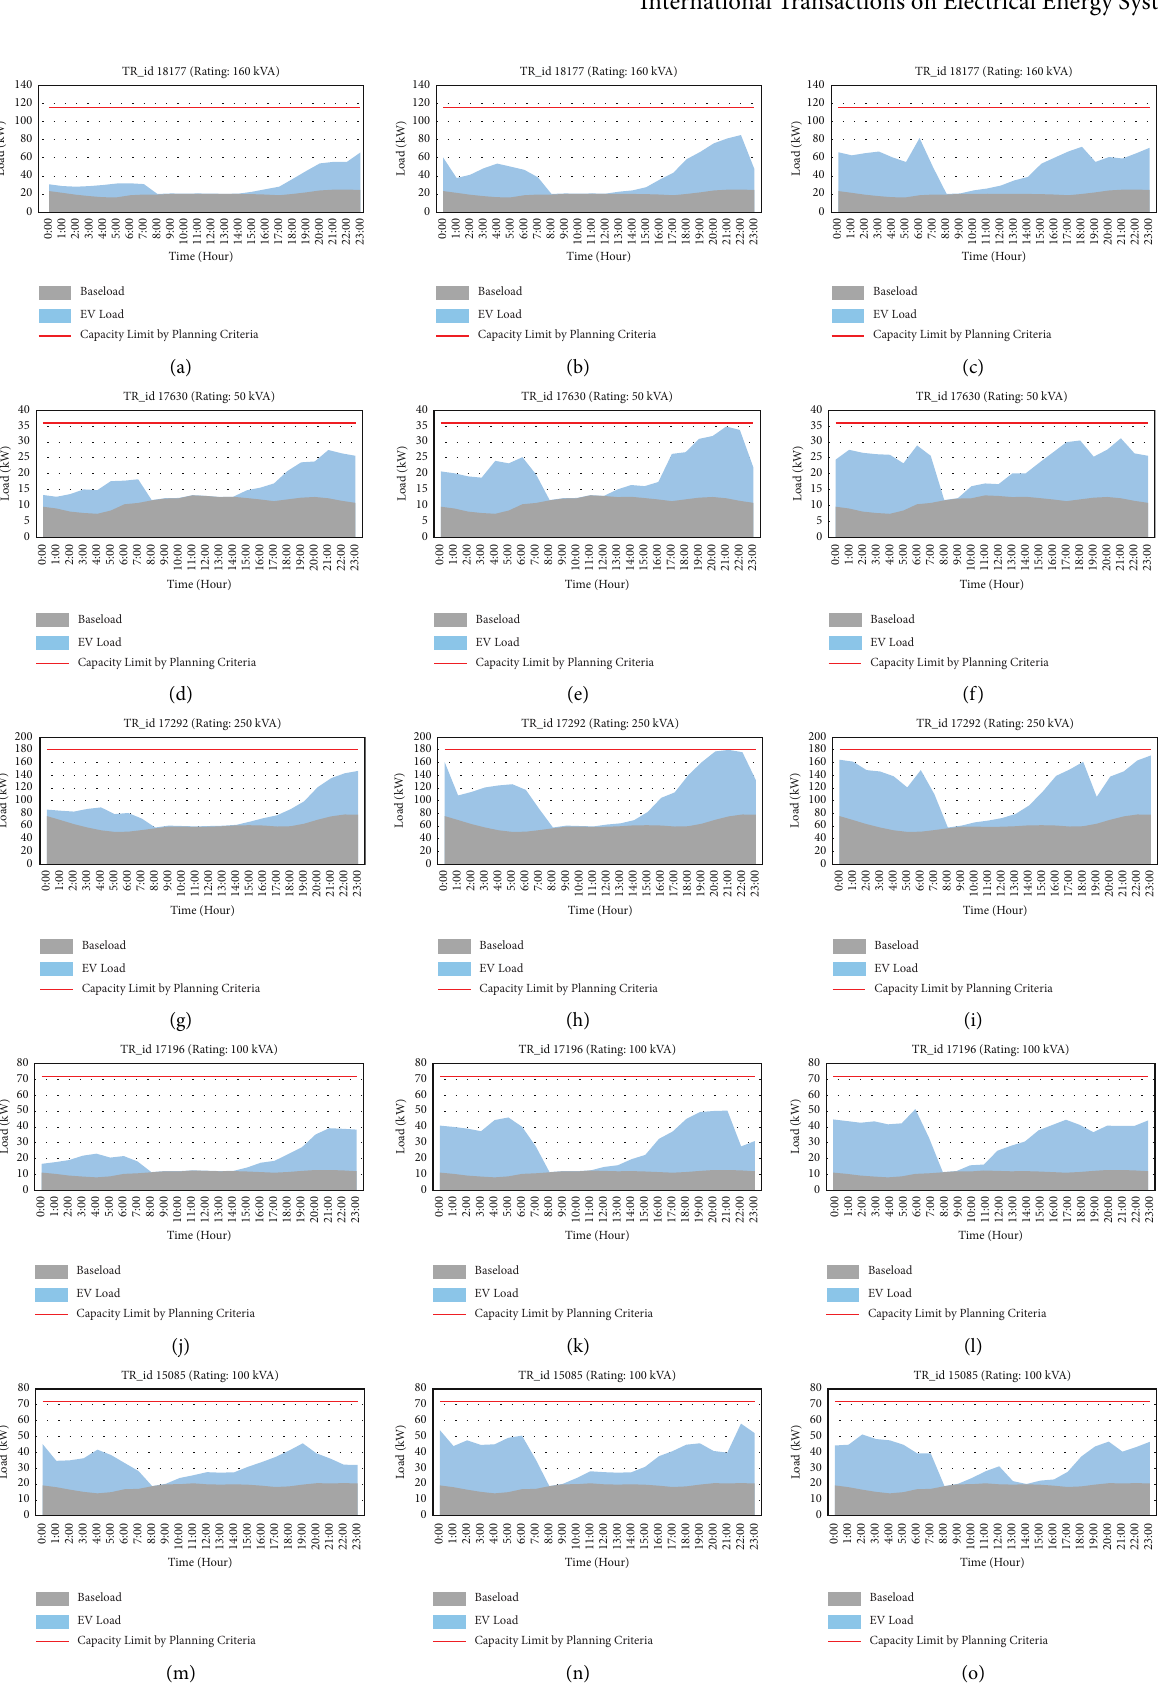
Figure 11: Capacity loading of sampled distribution transformers under fve primary feeders with the three scenarios of EV penetration for smart charging.DistributiontransformerID18177underprimaryfeederno.1with(a)10%,(b)30%,and(c)50%EVpenetration.Distributiontransformer ID 17630 under primary feeder no. 2 with (d) 10%, (e) 30%, and (f) 50% EV penetration. Distribution transformer ID 17292 under primary feeder no. 3 with (g)10%, (h) 30%, and(i) 50%EV penetration.Distribution transformer ID17196 under primaryfeeder no. 4 with (j) 10%, (k)30%, and (l) 50% EV penetration. Distribution transformer ID 15085 under primary feeder no. 5 with (m) 10%, (n) 30%, and (o) 50% EV